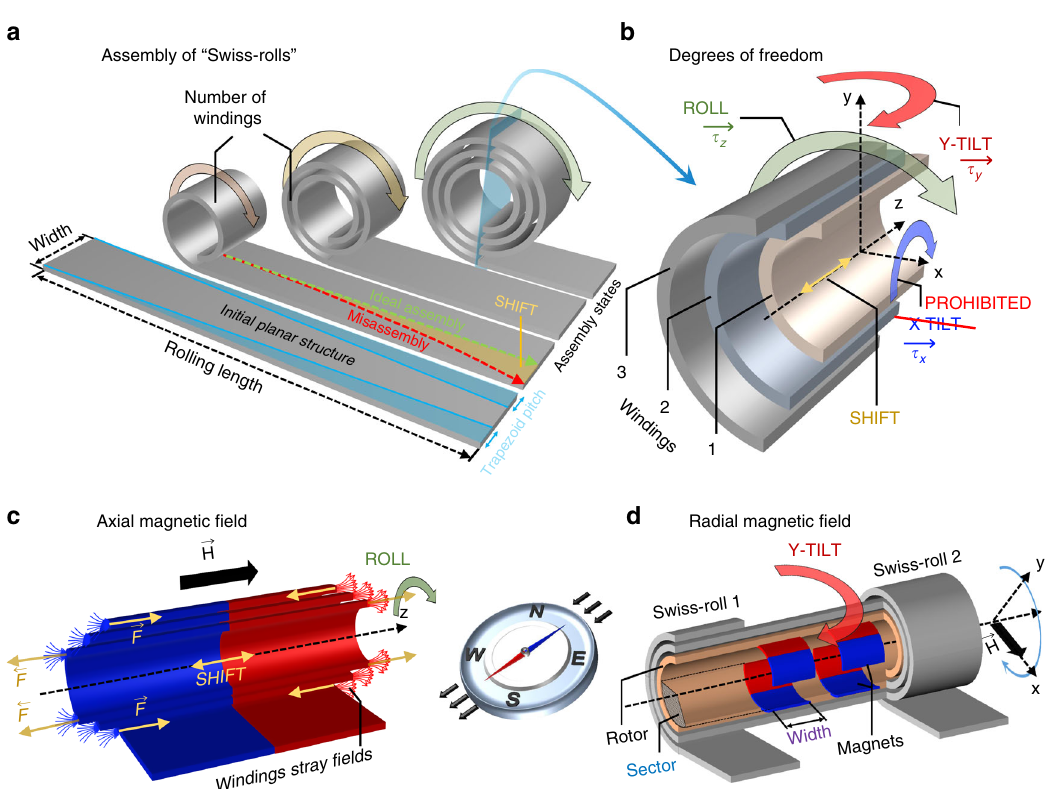
Fig. 1 Schematics of the “ Swiss-roll ” assembly and possible degrees of freedom. a “ Swiss-roll ” assembly process that starts with an initially planar structure of a speci fi c shape, either rectangular or trapezoidal with a de fi ned pitch. b Degrees of freedom available for “ Swiss-roll ” architecture during the assembly process. c Axial magnetic fi eld-assisted self-assembly of a “ Swiss-roll ” that is performed from a trapezoidal initial shape where magnetostatic forces play a key role in stabilization of the assembly. d Radial magnetic fi eld-assisted assembly of a “ Swiss-roll ” where rolling of the nanomembrane is achieved with a self-assembled rotor in a rotating external magnetic fi